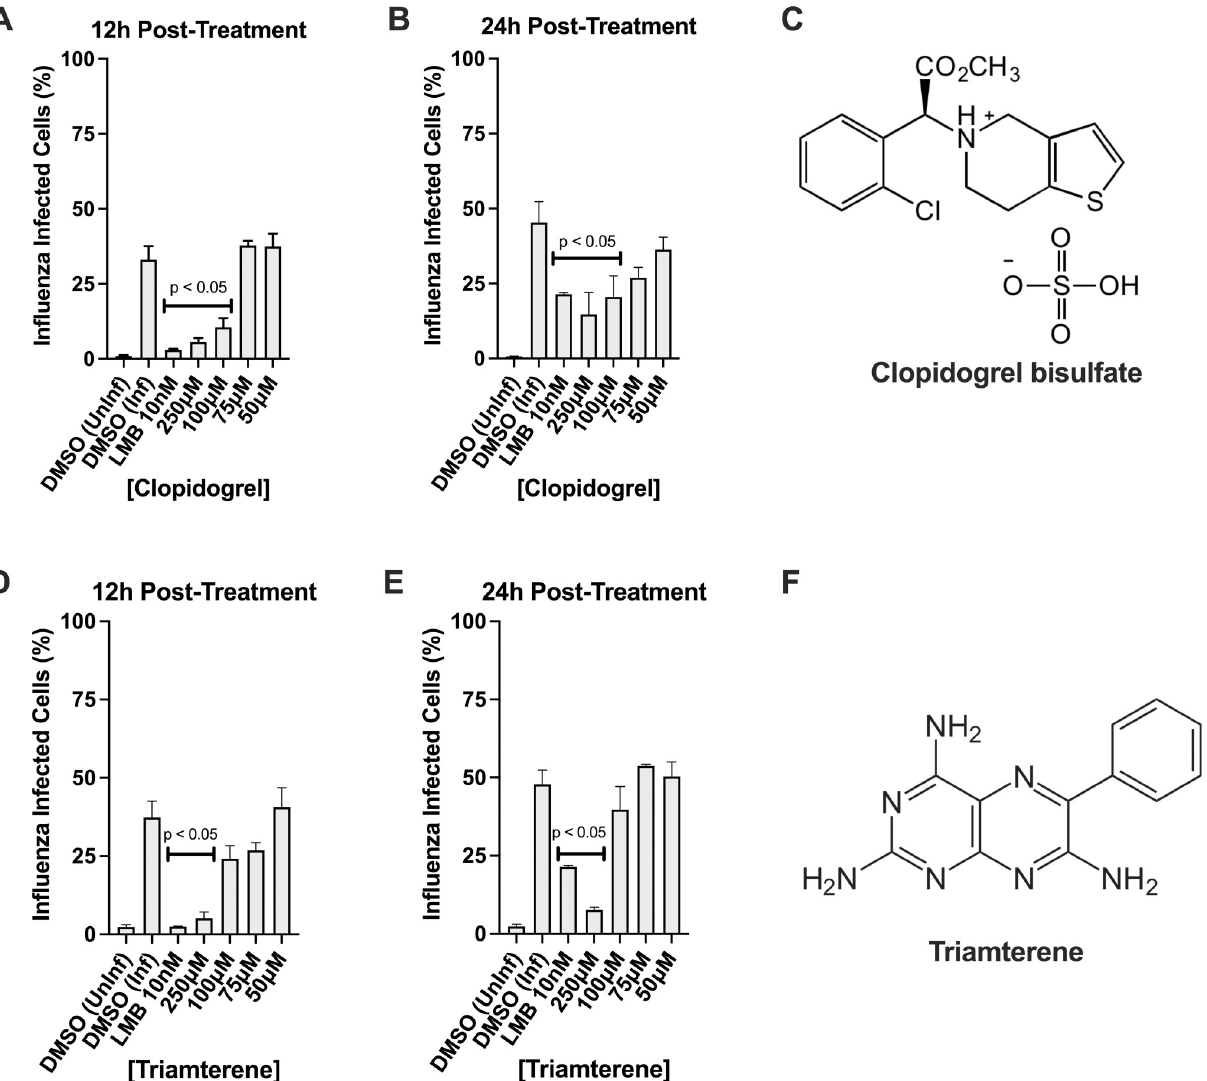
Fig 1. Clopidogrel and Triamterene have anti-influenza activity. A549 cells were infected for 1h before treatment with Clopidogrel for 12h (B) and 24h (C) or treated with Triamterene for 12h (E) and 24h (F) or LMB for 2h before infection after which the percent influenza-infected A549 cells was determined using an ArrayScan VTI HCS Reader and Cellomics Software. Presented are the structural formulas for compound SR-25990C, or Clopidogrel bisulfate (C) and compound SKF8542, or Triamterene (F). Shown is the mean ± standard errors for two independent experiments performed in triplicate. Statistically significant differences from DMSO-treated controls were determined by one-way analysis of variance with Dunnett’s multiple-comparison test (p < 0.05) and are indicated on graphs where appropriate.